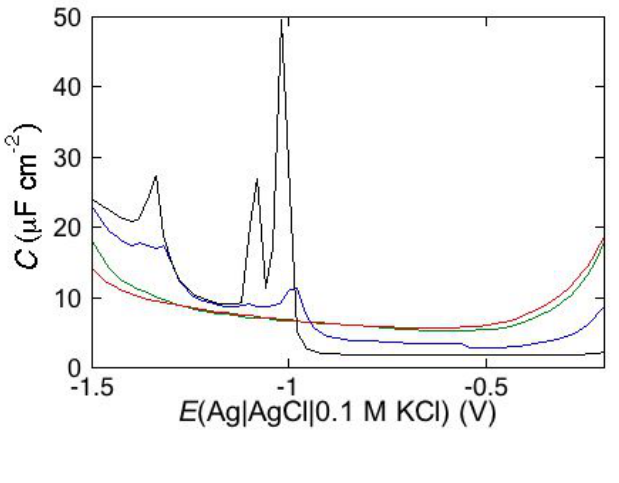
Figure 19. AC voltammograms at 75 Hz of a mercury-supported DOPC SAM in a pH 7 buffer solution of 0.1 M KCl in the absence of AmB ( black curve ), and in the presence of 0.4 ( blue curve ), 0.8 ( green curve ) and 4 μ M AmB ( red curve